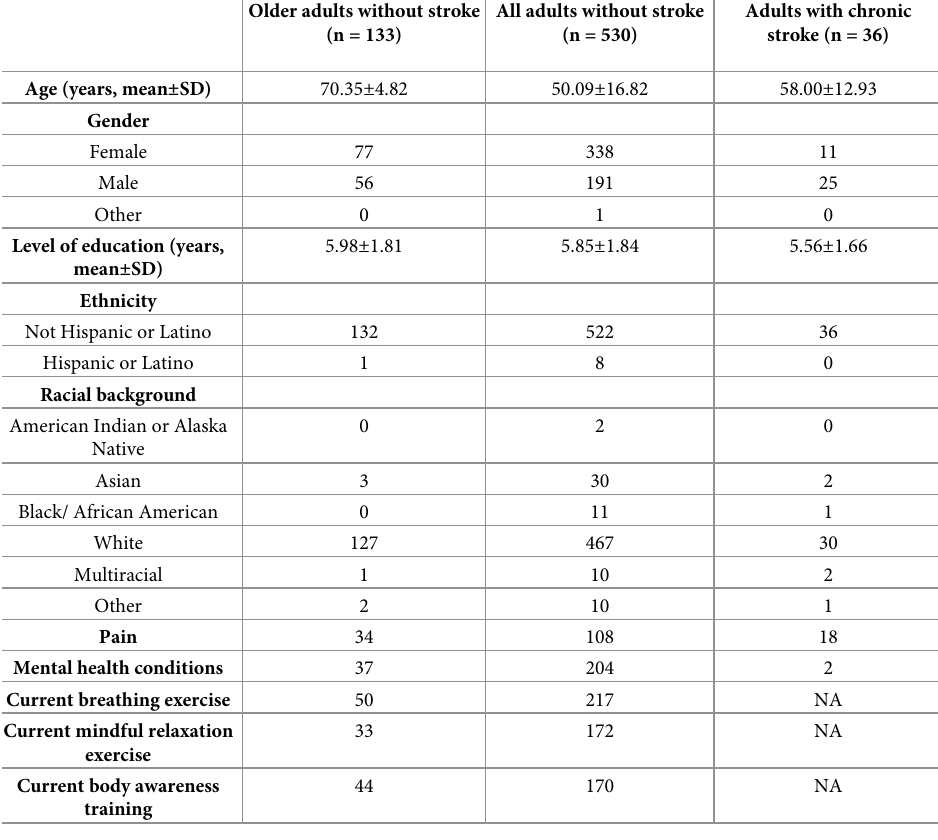
Table 1. Demographic and clinical characteristics of participants by